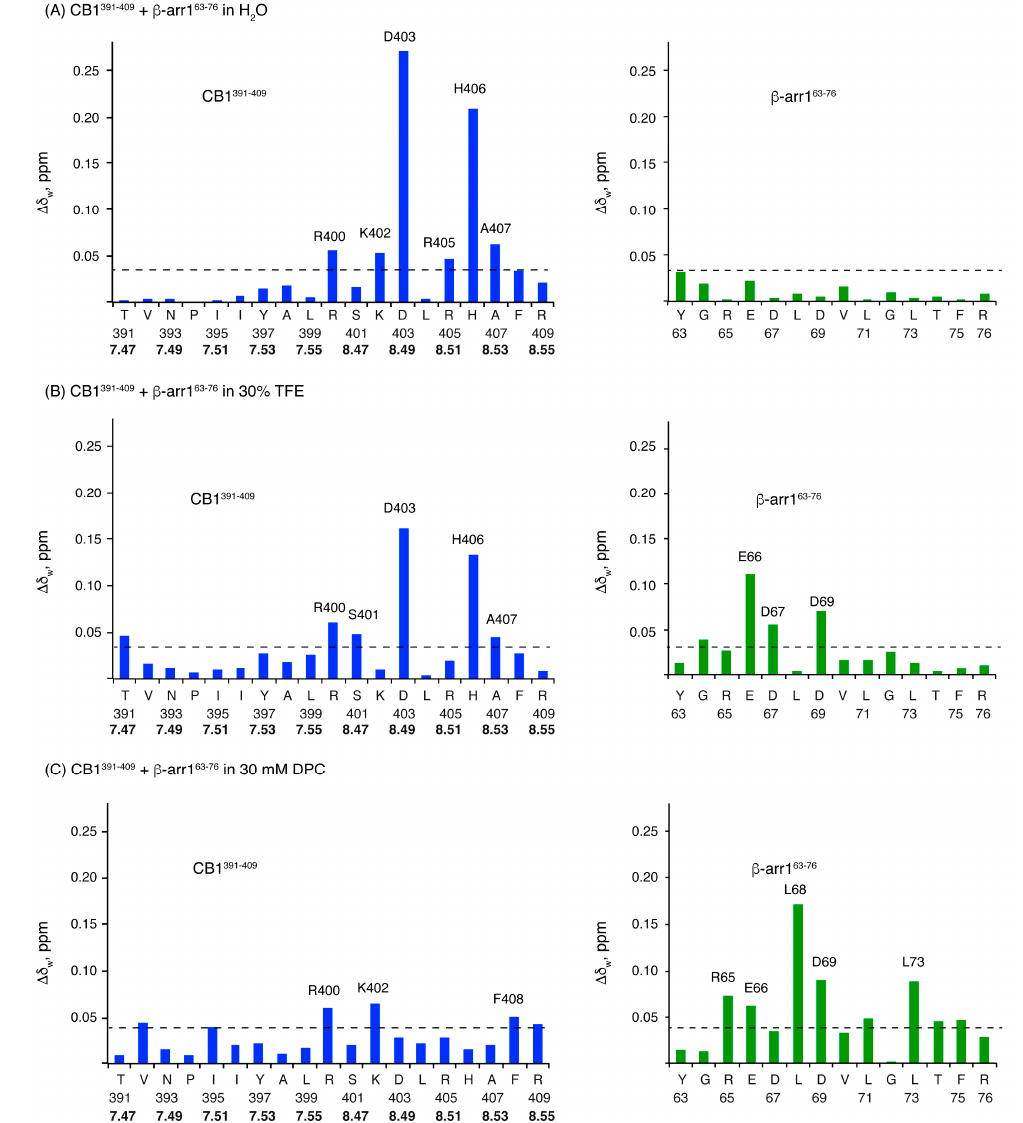
Figure 7. Weighted chemical shift differences ( Δδ w , ppm) plotted as a function of peptide sequence for CB1 391-409 (blue bars) and β -arr1 63-76 (green bars). Δδ w values are calculated as Δδ w =[( Δδ H α interaction ) 2 +( Δδ NH α interaction ) 2 +(( Δδ C α interaction ) 2 /4)] 1/2 , where Δδ H α interaction , Δδ NH α interaction and Δδ C α interaction are the chemical shift differences of the corresponding nuclei for the free peptides and in the mixture in H 2 O ( A ), 30% TFE ( B ) or 30 mM DPC ( C ) at pH 5.5 and 25 ◦ C. In the case of CB1 391-409 , the Ballesteros and Weinstein numbering is shown in